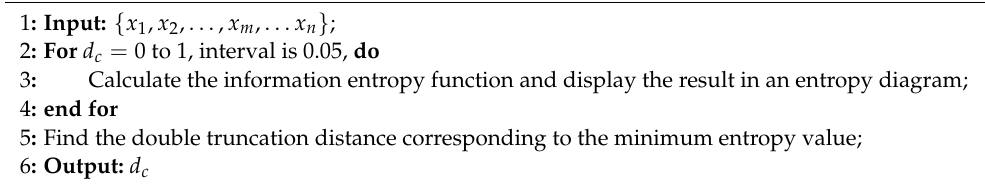
Algorithm 1 : Adaptation of double truncation